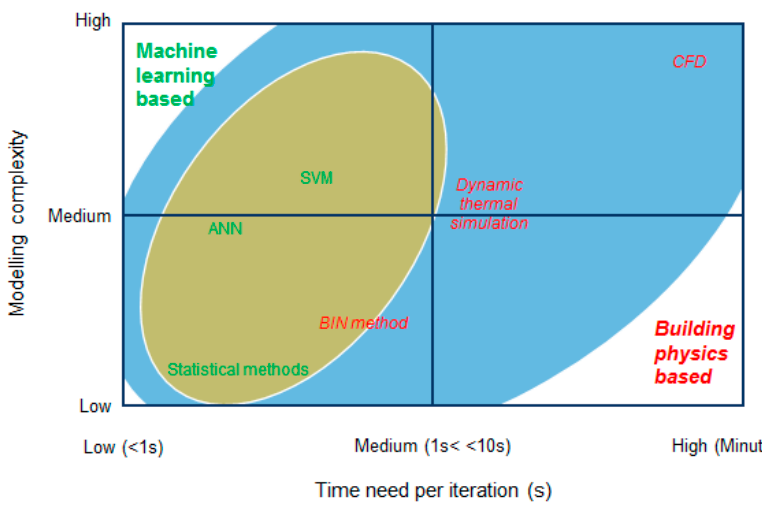
Figure 1. Comparative performances of some of building energy forecasting